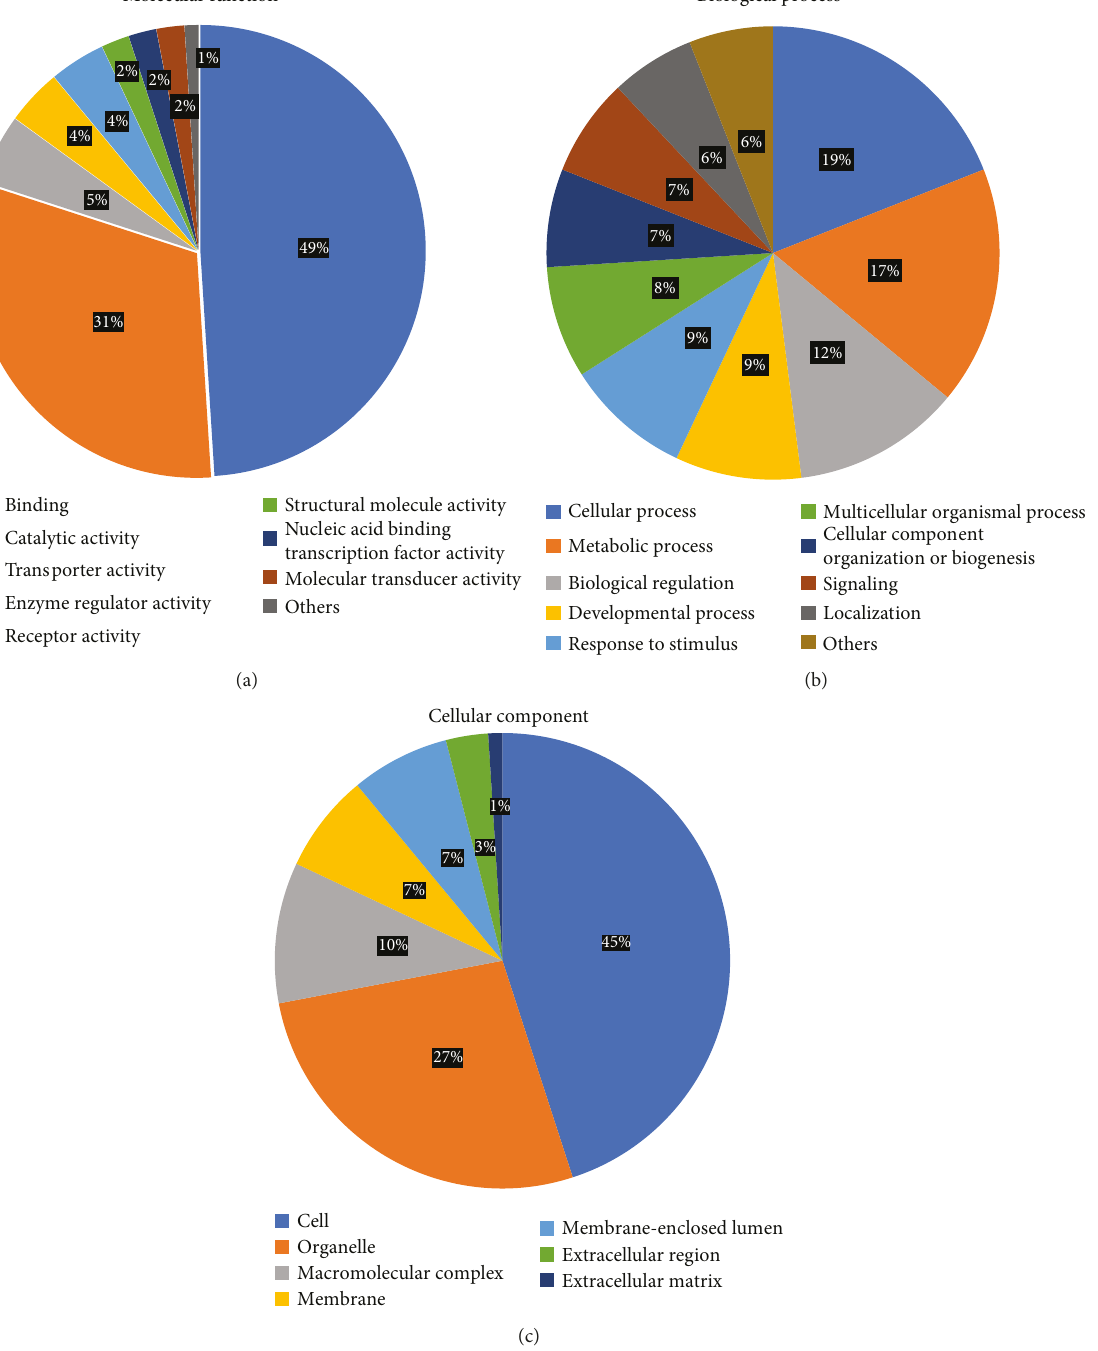
Figure 4: Gene ontology terms assigned to the assembled cDNA transcripts of greater amberjack. The gene ontology annotations under the three main categories: (a) molecular function, (b) biological process, and (c) cellular